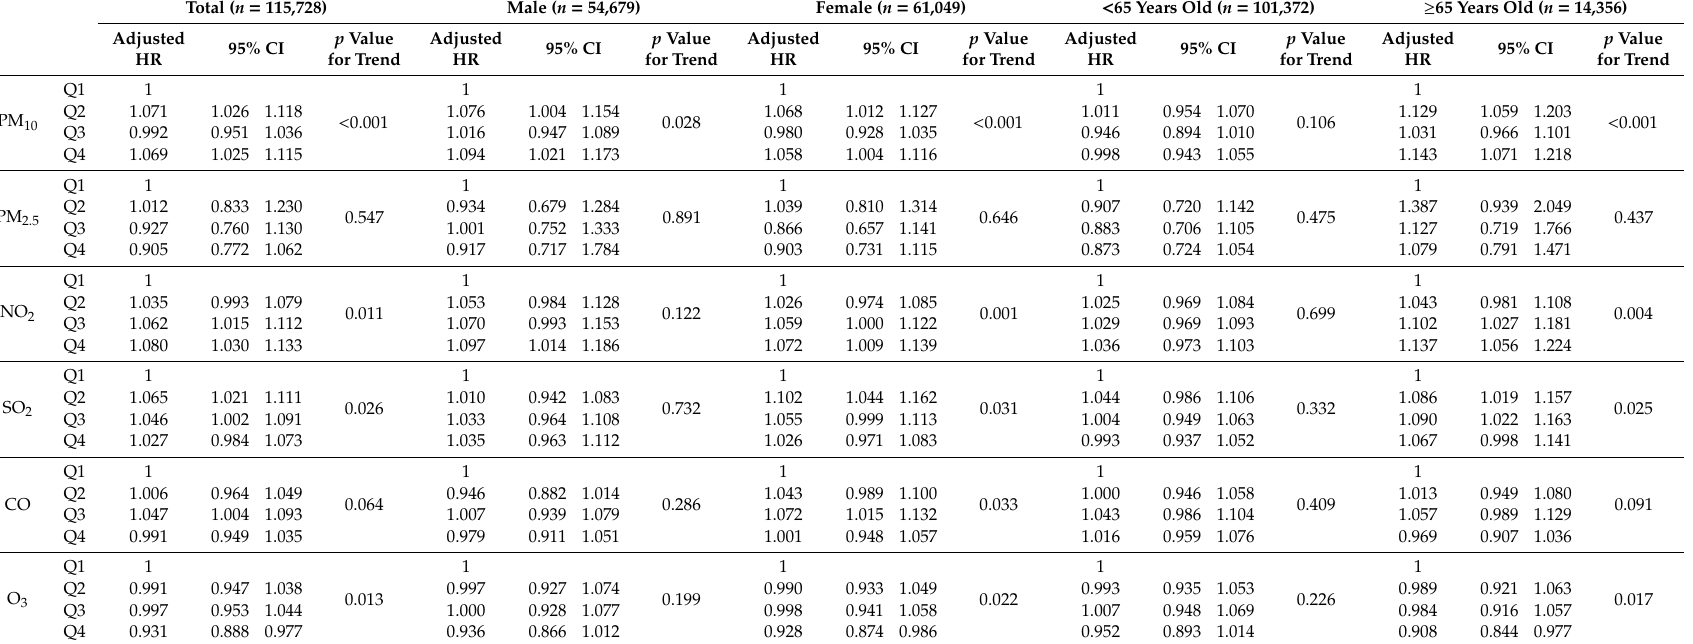
Table 2. Hazard ratios (HR) of cataract incidence according to the levels of air